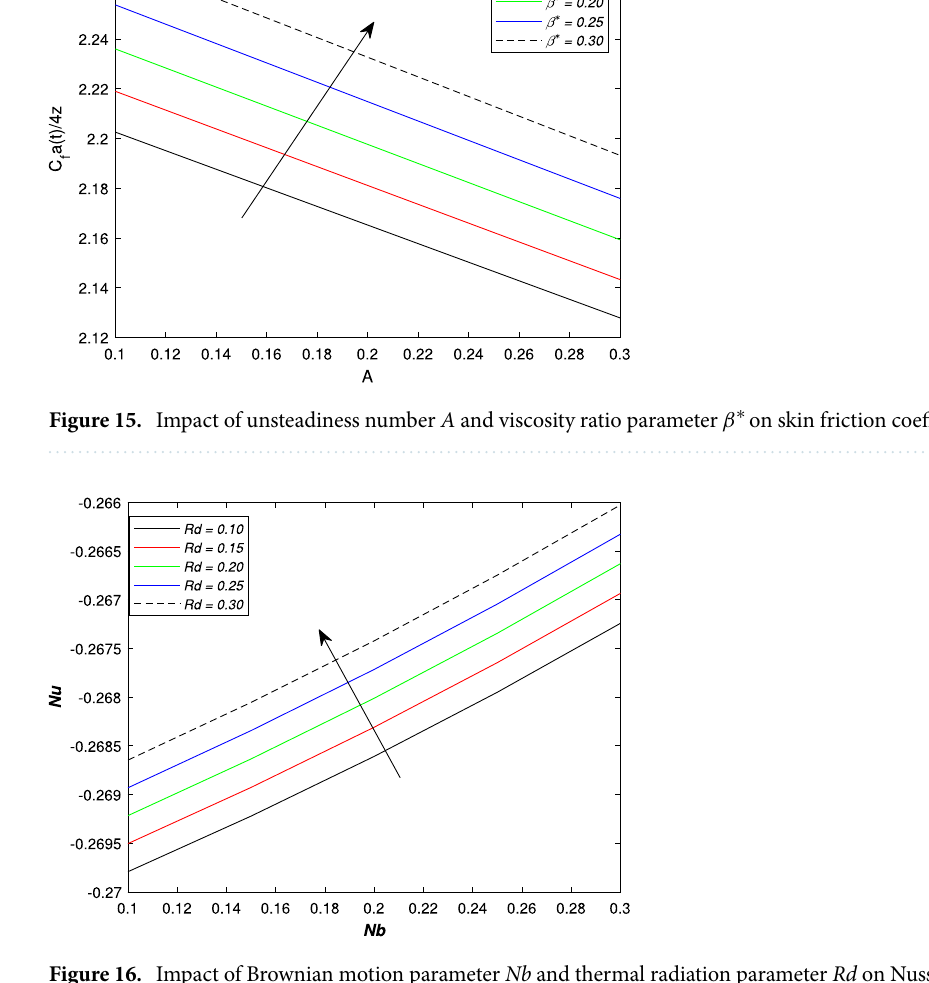
Figure 16. Impact of Brownian motion parameter Nb and thermal radiation parameter Rd on Nusselt